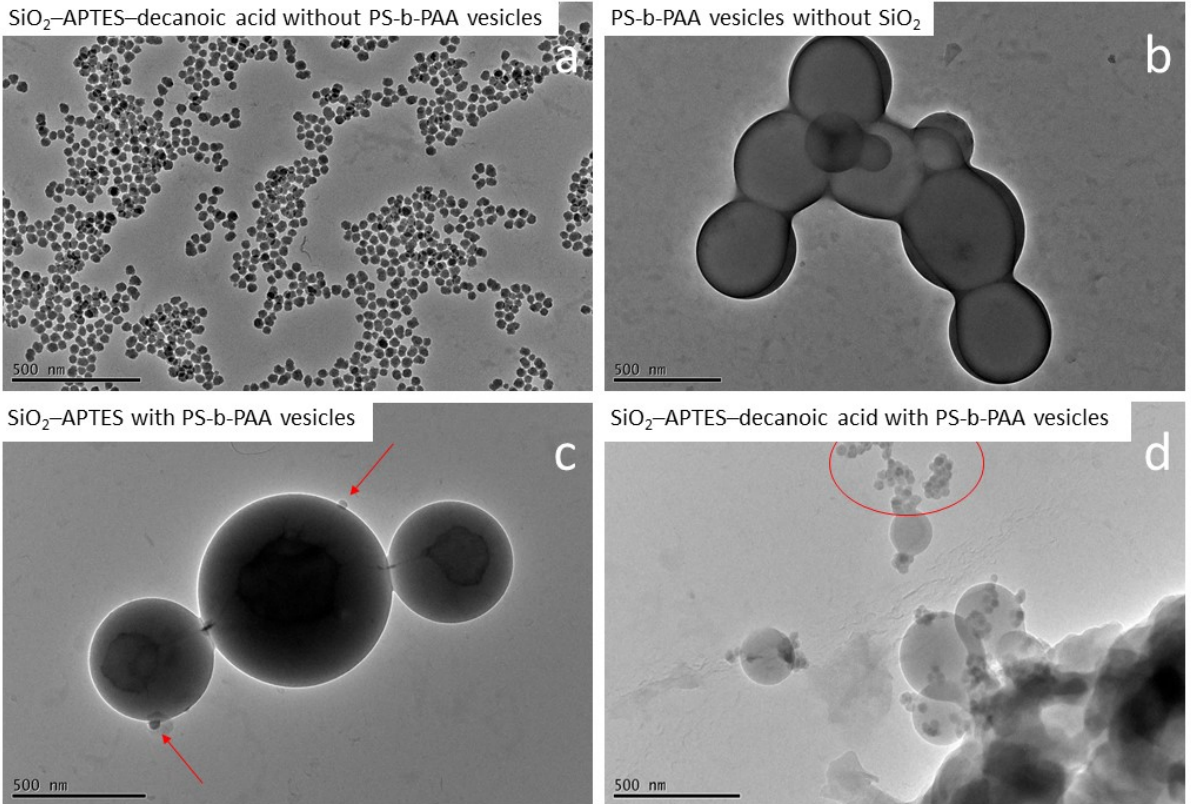
Figure 9. TEM images of the encapsulation experiments of silica nanoparticles in PS-b-PAA vesicles. ( a ) SiO 2 –APTES–decanoic acid nanoparticles (20 nm) without PS-b-PAA vesicles as a reference. ( b ) PS-b-PAA vesicles without SiO 2 as a reference. ( c ) Encapsulation experiment with SiO 2 –APTES (20 nm). Red arrows indicate silica nanoparticles attached to the vesicle surface. ( d ) Encapsulation experiment with SiO 2 –APTES–decanoic acid (20 nm). Agglomerates of silica nanoparticles outside the vesicles are visible encircled in red.